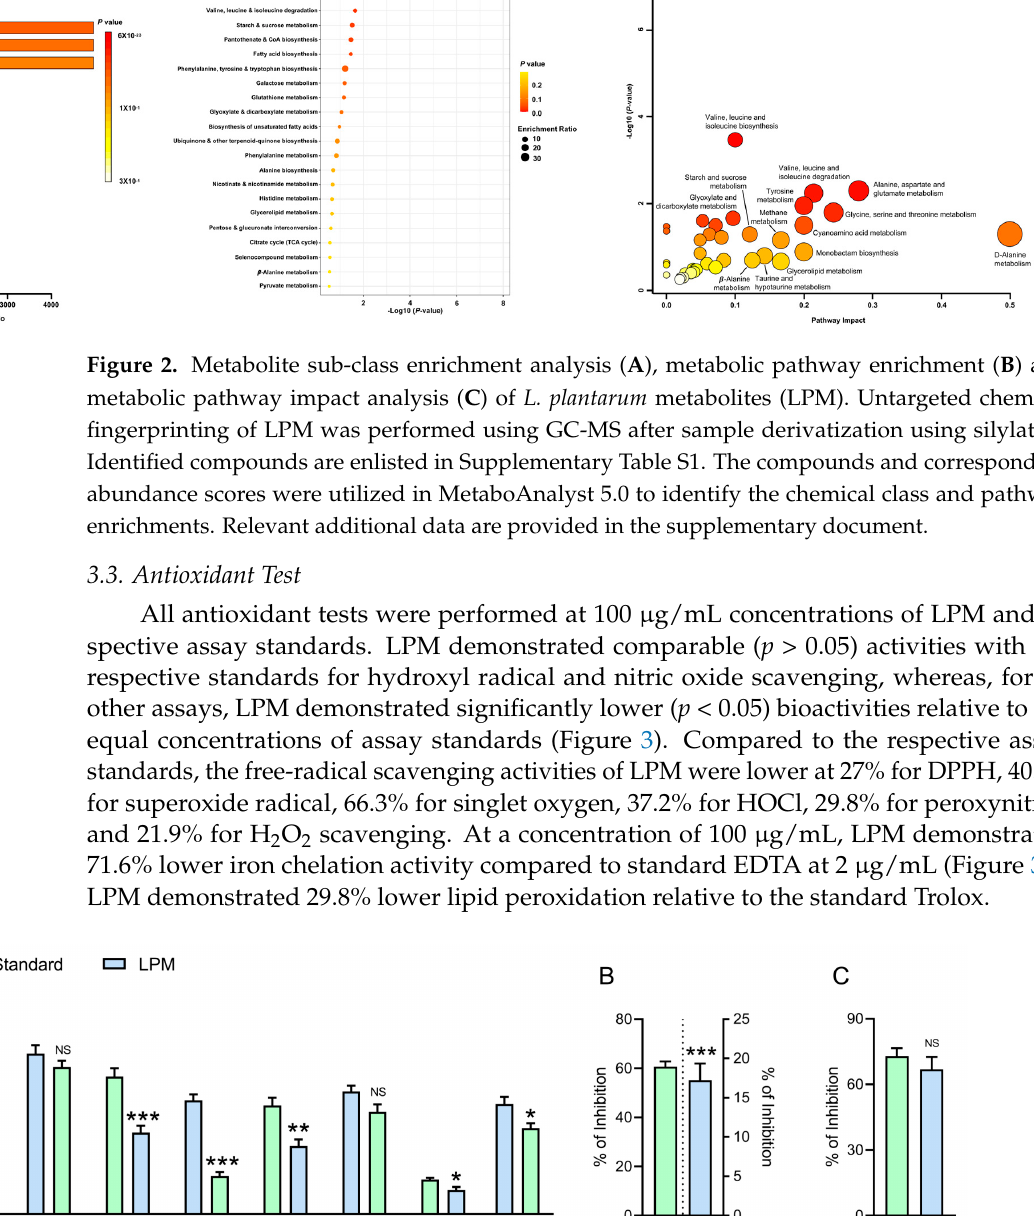
Figure 3. Results of in vitro antioxidant and free-radical scavenging activities of L. plantarum metabo- lites (LPM). LPM at 100 µ g/mL was compared with the equal concentration of respective assay standards. Standards used in specific assays were ascorbic acid (DPPH assay and hypochlorous acid), mannitol (hydroxyl radical scavenging), quercetin (superoxide anion), lipoic acid (singlet oxygen scavenging), curcumin (nitric oxide), gallic acid (peroxynitrite scavenging), sodium pyruvate (hydro- gen peroxide), ethylenediaminetetraacetic acid (iron chelation activity) and Trolox (lipid peroxidation assay). Data show ( A ) general antioxidant assays, ( B ) Iron chelation assay, ( C ) Lipid peroxidation assay. Data analysis was performed using 2-tailed unpaired t -tests. Data represented as mean ± SEM of 6 measurements. * p < 0.05, ** p < 0.01, *** p < 0.001 and NS p >